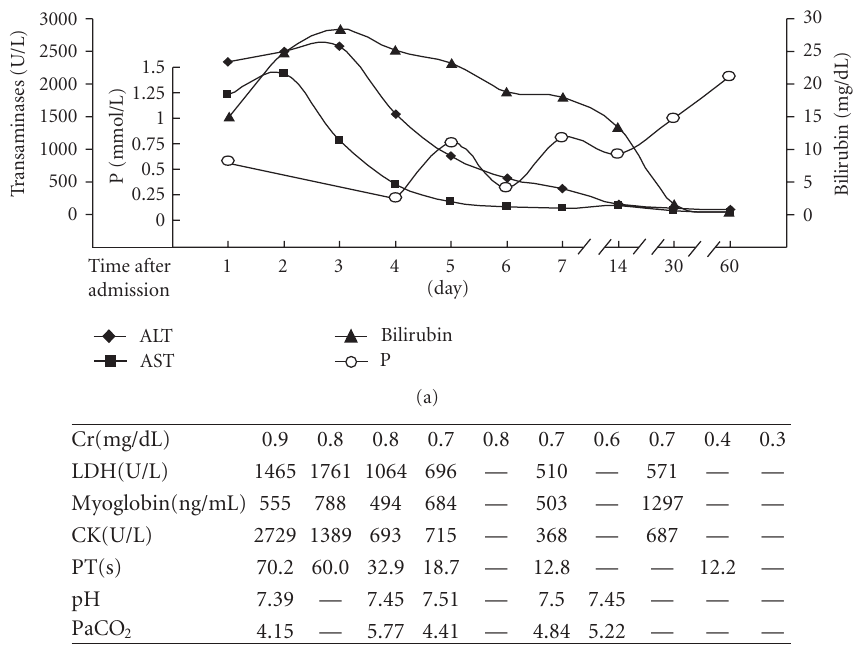
Figure 1: Basic laboratory parameters of the patient presenting with AHF during the course of EHS. In (a), ALT and AST began to be decreased from day 3 after admission in our ICU and recovered to be normal within 2 weeks. Total bilirubin declined more slowly than transaminases. In the early stage of EHS, hypophosphatemia was evident. (b) Showed the dynamic change of Cr, LDH, CK, PT and arterial blood gas analysis with pH and PaCO 2 within 2 months in our hospital. ALT, alanine aminotransferase; AST, aspartate aminotransferase;